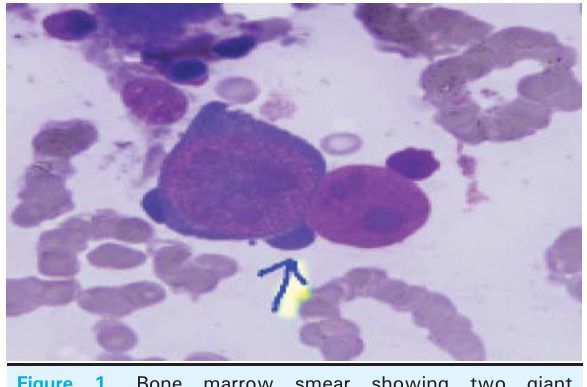
Figure 1. Bone marrow smear showing two giant proeythroblasts. One intact with intranuclear eosinophilic inclusion body like nucleoli. Arrow points to ‘dog ear’ cytoplasmic projections. Adjacent is a denuded nucleus